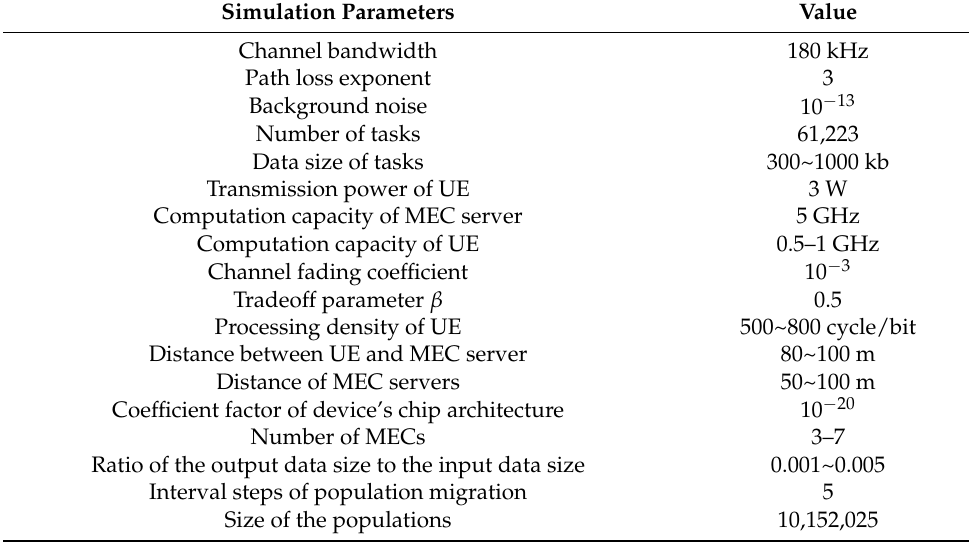
Table 2. The simulation